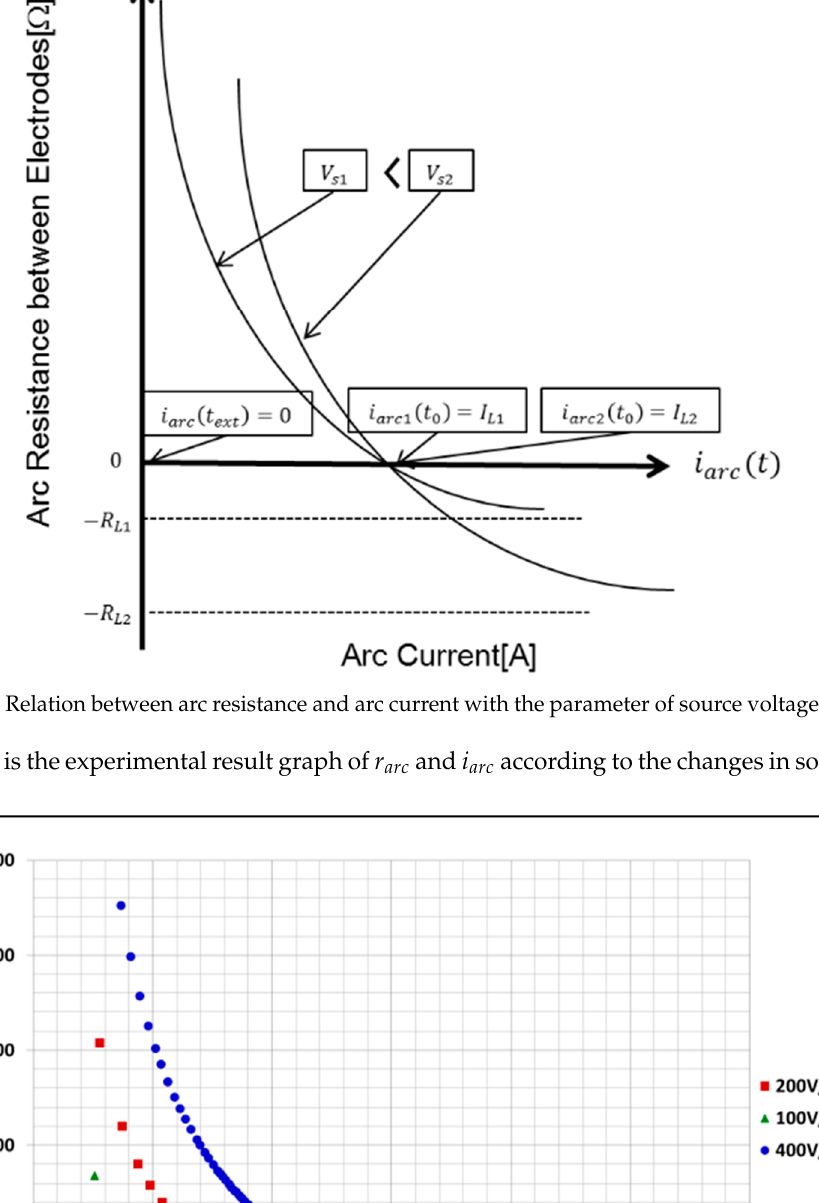
Figure 13. Arc resistance and arc current experimental results (source voltage change).